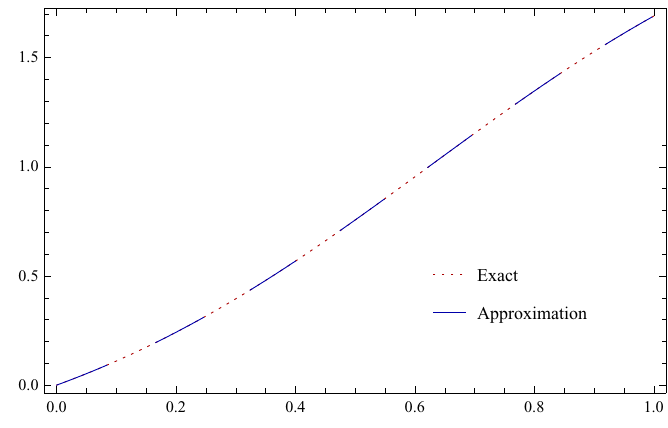
Figure 2. Plot of f(t) obtained from present method with N = 1, M = 5, and exact